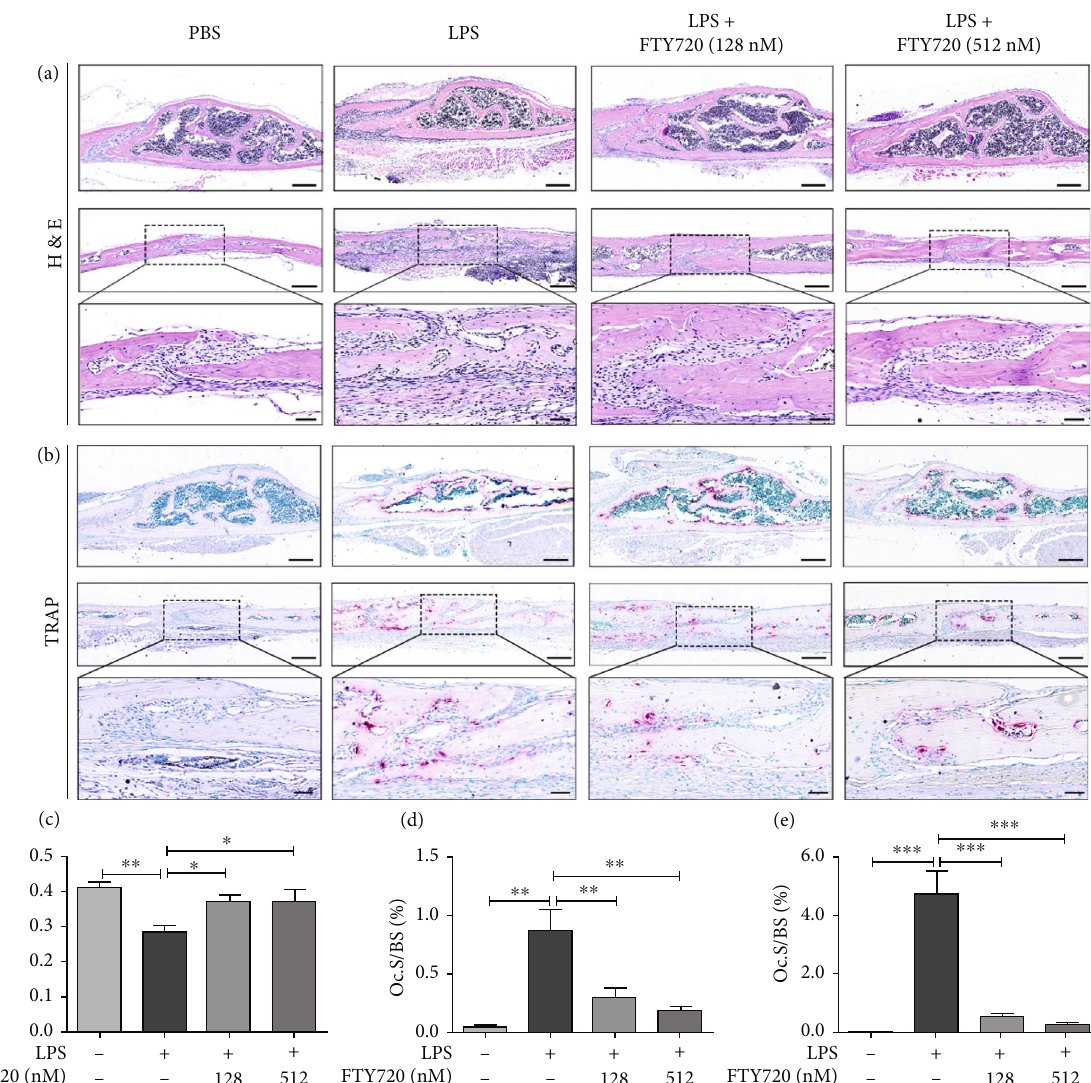
Figure 5: FTY720 treatment partially restored cranial bone morphology and inhibited osteoclastogenesis in vivo. (a) Hematoxylin-eosin (H&E) staining of the region of interest. Median skull, scale bar, 200 μ m (top panels), cranial suture, 200 μ m (middle panels), and 50 μ m (bottom panels). (b) TRAP staining of the region of interest. Median skull, scale bar, 200 μ m (top panels), cranial suture, 200 μ m (middle panels), and 50 μ m (bottom panels). (c – e) Quantitative analysis of the skull middle bone marrow cavity area (c) and the number of TRAP-positive stained osteoclasts in the skull median (d) and on the skull cranial sutures (e) in the PBS ( n = 6 ), LPS ( n = 6 ), and LPS with low ( n = 5 ) or high ( n = 5 ) FTY720 groups. Data are expressed as the mean ± SEM . ∗ P < 0 : 05 , ∗∗ P < 0 : 01 , ∗∗∗ P < 0 : 001 by one-way ANOVA with Tukey ’ s post hoc test (b –